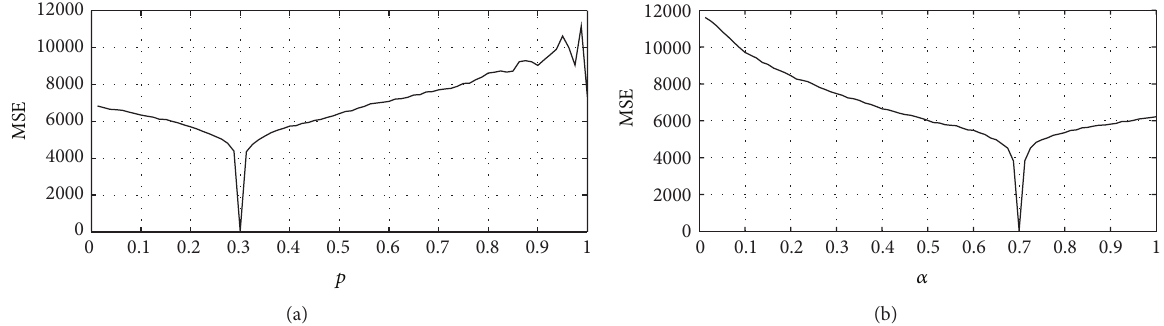
Figure 6: (a) MSE (between secret image and decrypted image) as a function of order of FrMT. (b) MSE (between secret image and decrypted image) as a function of order of